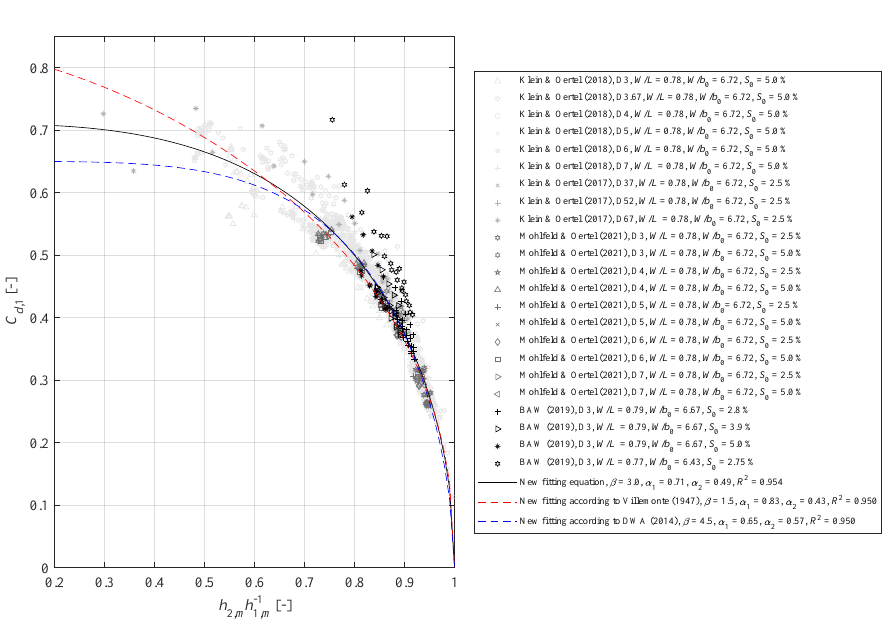
Figure 4. Discharge coefficients and new fitting equations according to Equation (3) based on Poleni (Equation (2))